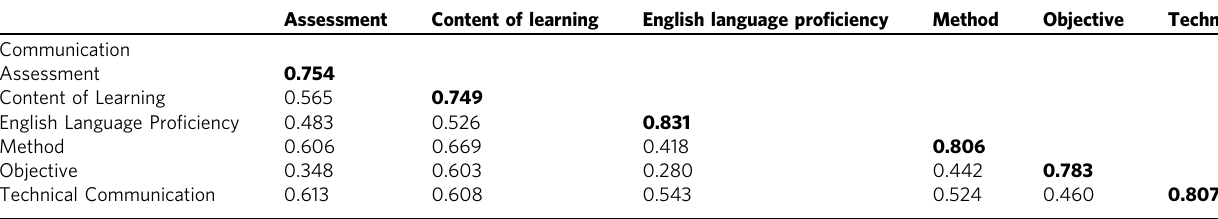
Table 11 Discriminant validity result based on the Fornell and Larcker ’ s (1981) criterion for the HOCs.